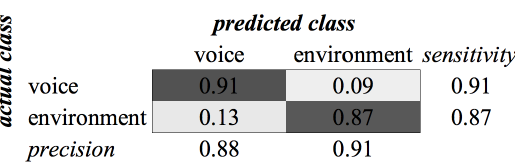
Figure A4. KHMM confusion matrix of Environment/Voice classification for MFCC feature